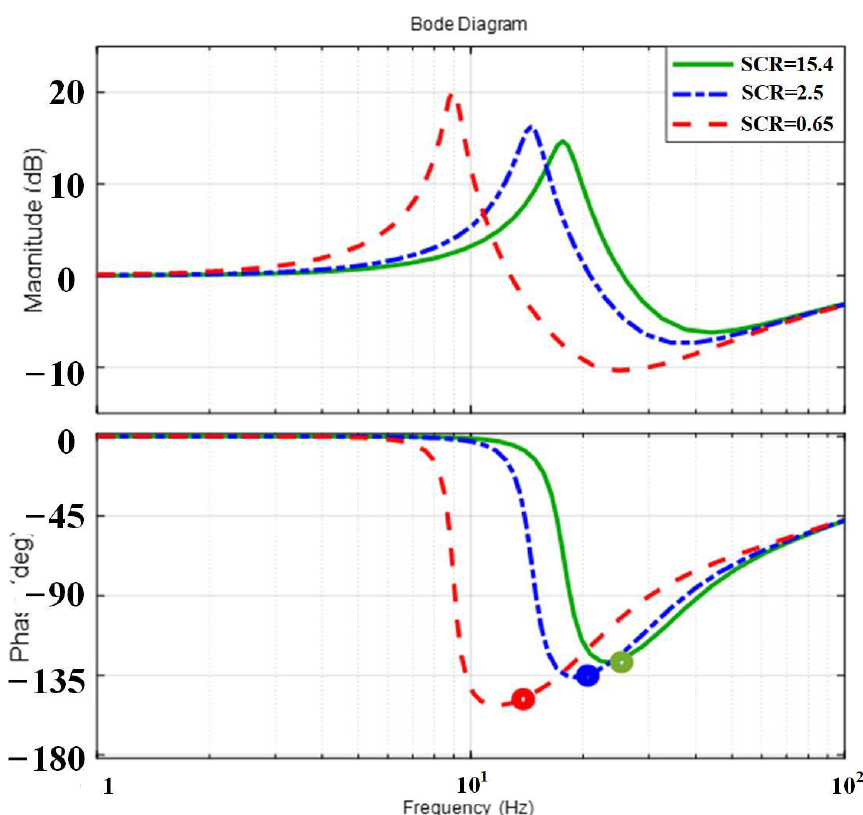
Figure 14. Bode diagram of G 2 ( s ) for different grid strengths.